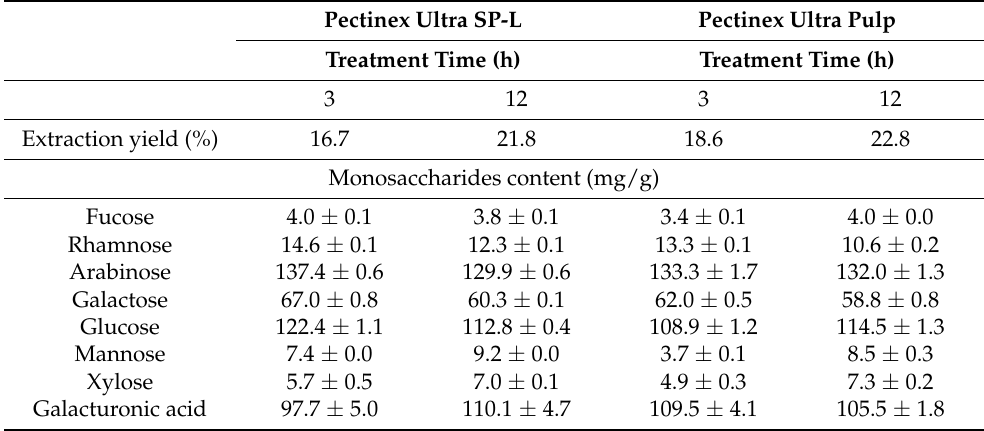
Table 1. Extraction yield and monosaccharide composition of citrus peel hydrolysates treated with different types of enzyme and incubation times.